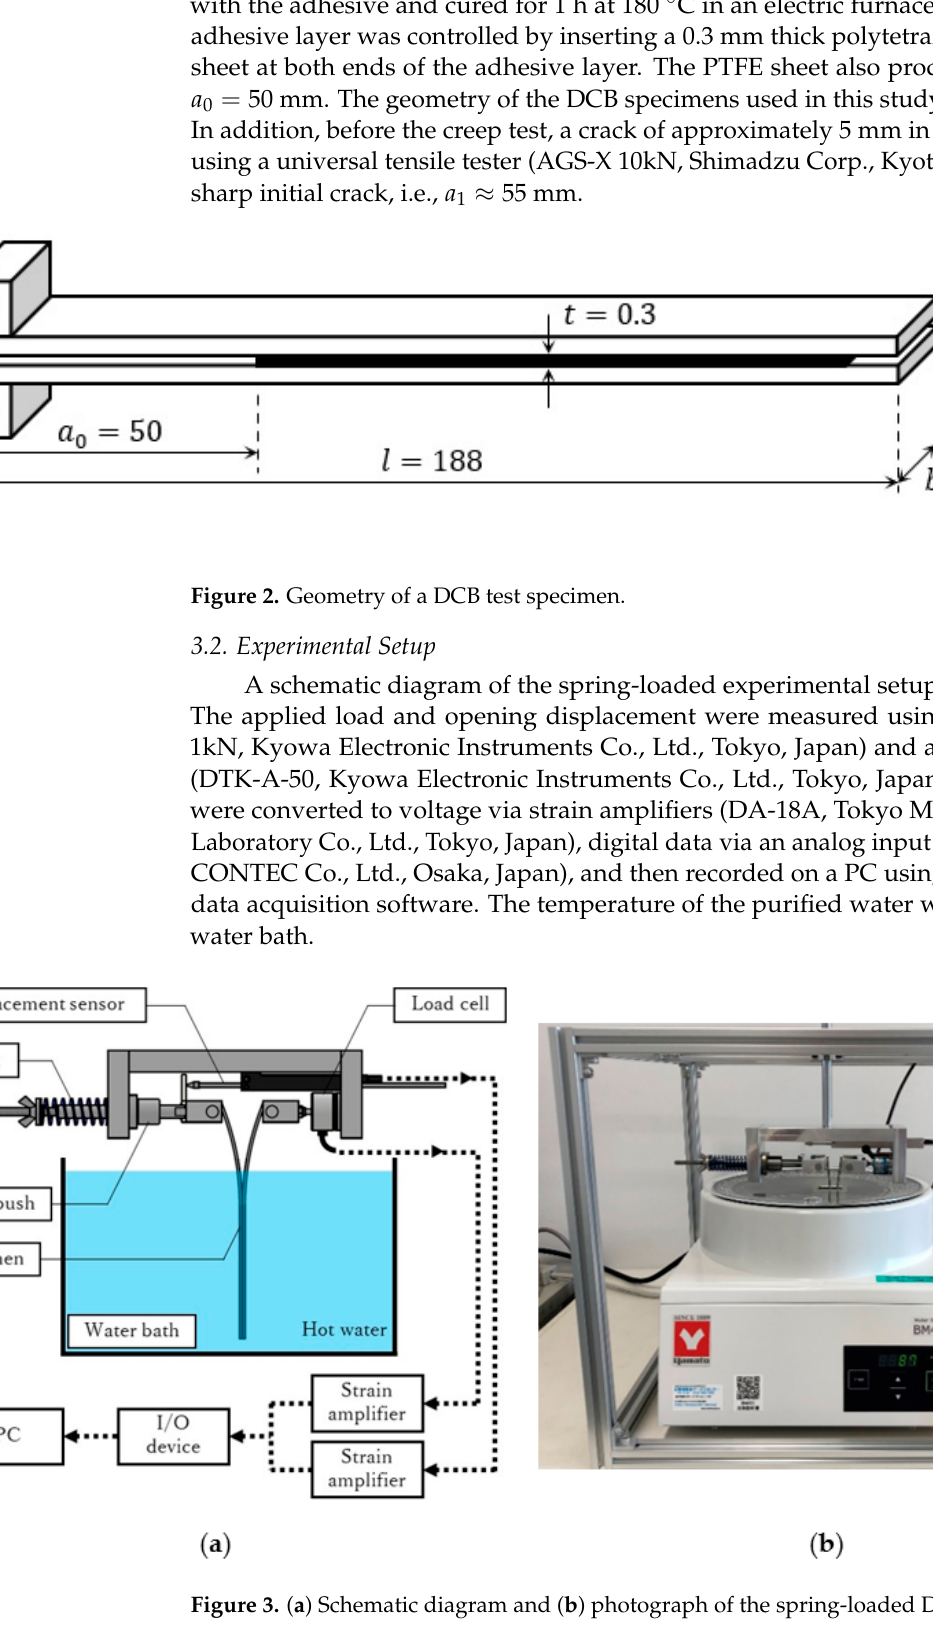
Figure 3. ( a ) Schematic diagram and ( b ) photograph of the spring-loaded DCB test setup.